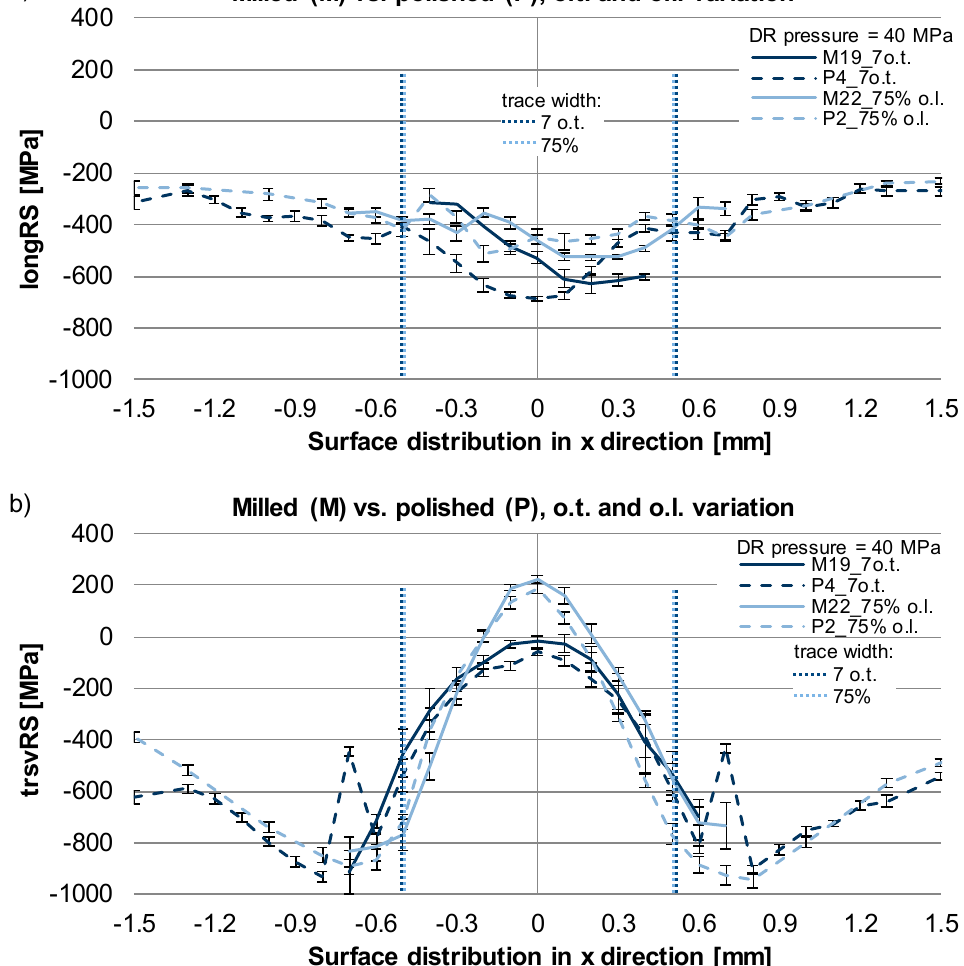
Figure 7. Residual stress surface distribution (measured with Seifert) after DR by different pre-machining states, i.e., milled and DR (designation “M”) or milled, polished and DR (designation “P”), overturn (o.t.) and overlapping (o.l.) variation; ( a ) longitudinal residual stresses (longRS) and ( b ) transverse residual stresses (trsvRS).